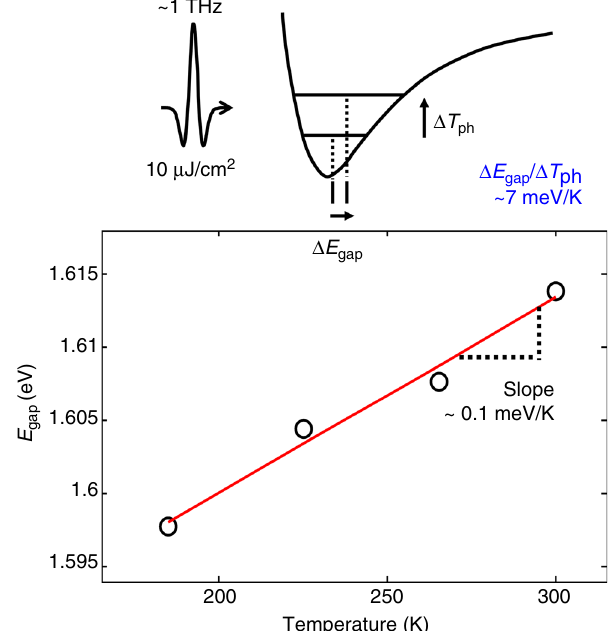
Fig. 5 Ef fi ciency of the 1 THz phonon in increasing the band gap. The band gap of MAPbI 3 varies linearly with temperature at 185 – 300 K (in the tetragonal phase). Using a linear fi t to the data, we extract a variation of the gap by 0.1 meV/K. The population increase of the 1 THz phonon by THz pump (10 μ J/cm 2 ) leads to the blue-shift of the band gap ( Δ E gap ) by 0.3 meV. The effective phonon temperature ( Δ T ph ), which is the temperature equivalence of the population increment is estimated to be ~ 0.04 K, which gives higher slope, ~ 7 meV/K, than the overall slope, ~ 0.1